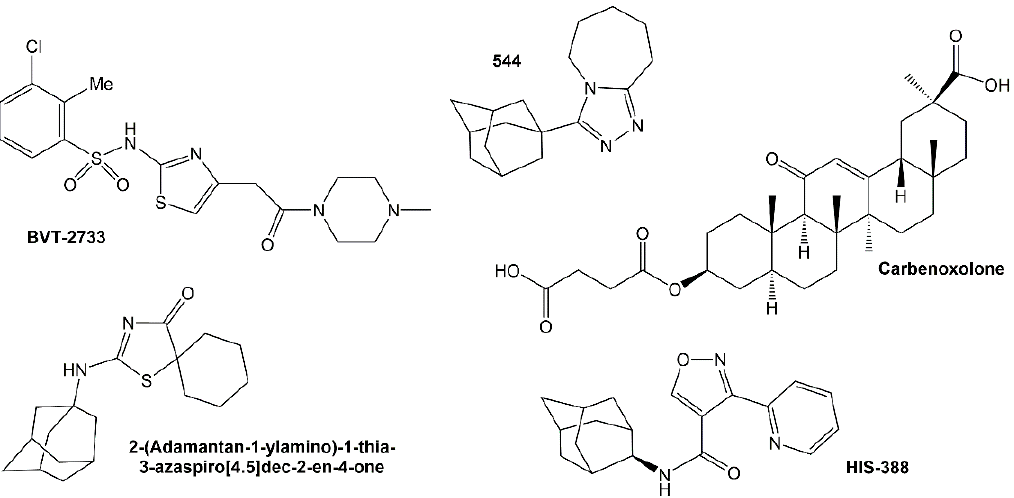
Figure 3. Structures of selected 11 β -HSD1 inhibitors .